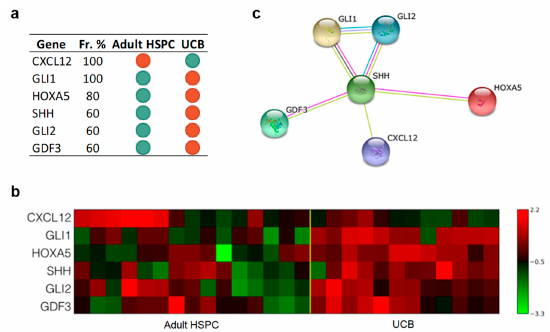
Figure 4. The results indicated that only six genes are sufficient to discriminate UCB from adult HSPC. Further, the Kyoto Encyclopedia of Genes and Genomes (KEGG) enrichment highlighted that Hedgehog pathway appears to be upregulated in UCB compared to adult HSPC. Panel a : Gene Signature. List of 6 gene symbols selected by the l 1 l 2FS procedure. For each gene, we report the corresponding frequency percentage score and the gene expression relative to the comparison between indicated groups: Green dots, downregulation; red dots, upregulation. Panel b : Heatmap associated with the 6 genes of the signature discriminating between adult HSPC (15 samples) and UCB (12 samples). The expression data for each gene has been scaled and is represented by pseudo-colors in the heatmap. Red color corresponds to a high level of expression and green color corresponds to a low level of expression as also shown in the color bar. Panel c : Association network of the genes in the signature between adult HSPC (15 samples) and UCB (12 samples) inferred by the STRING online tool. The identified connections are of five different types: Text mining (lime green), Experiments (magenta), Databases (Turquoise), Coexpression (Black), Homology (purple). 3.3.2. The Set of the Expression Differences of Fifty-Two Genes Discriminates Cord Blood CD34+ Cells before and after Transplantation The set of the expression differences of fifty-two genes (Figure 5 panel a), including NANOG , OCT4 , PTEN , HOXB3 , and HOXB4 , differentiated between CD34+ cells from UCB and after UCBT with an accuracy of 88% and an MCC value of 0.8. The corresponding heatmap is presented in Figure 5 panel b. Figure 5 panel c presents the associated gene network inferred by STRING. Supplementary Table S3B reports the pathways we found enriched in KEGG using the identified signature. In particular, among the 52 genes, the analysis extrapolated genes of the NOTCH pathway ( NOTCH3 , NOTCH1 , HES1 , JAG2 ) and genes involved in cytokine–cytokine receptor interaction.